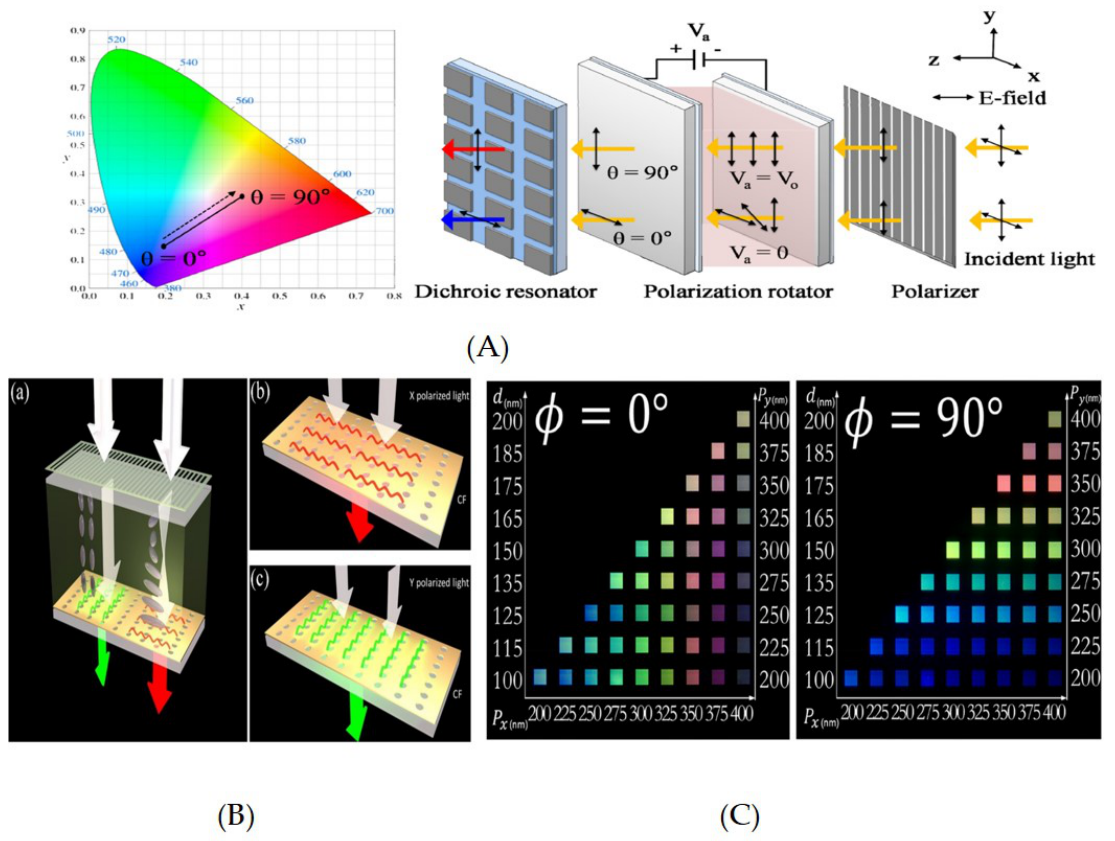
Figure 10. Liquid crystal-based color filters. ( A ) Setup of electrically tunable color filter exploiting a visible dichroic resonator with subwavelength metal-dielectric resonant structure in conjunction with a LC-based polarization controller. Reproduced with permission of [19]. Copyright The Optical Society, 2013. ( B ) Schematic diagram of electrically tunable color filter exploiting TN-LC and rectangular lattice of nanoholes on Al film to control the polarization of incident light, and ( C ) Optical photographs of printed colors in TM and TE mode. Reproduced with permission of [244]. Copyright